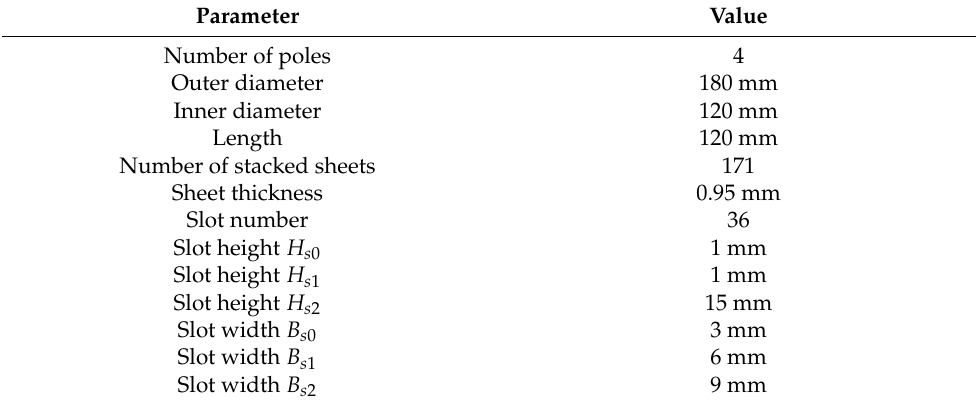
Table 3. Stator dimensions of the IM.